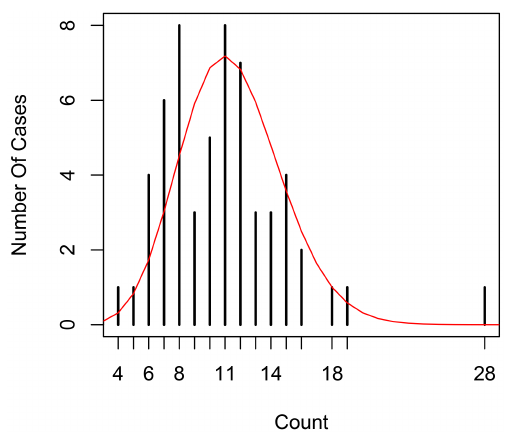
Figure 2. The observed data and a Poisson fit for the number of tropical storms between 1951 and